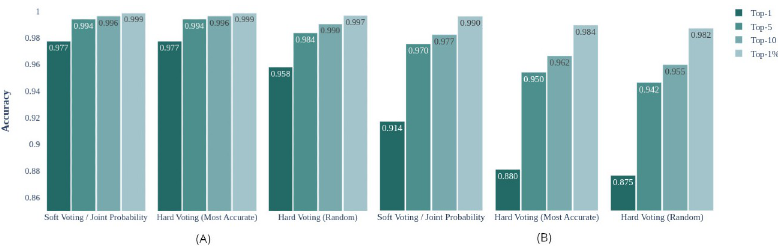
Fig 14. Comparison between aggregation method for the best performing combinations. A : CVUSA and B : CVACT.